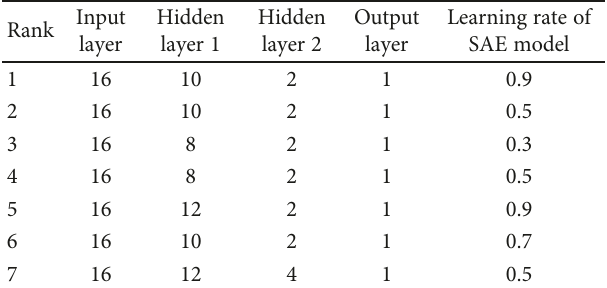
Table 8: The fi rst seven optimal parameter arrays obtained by the grid search